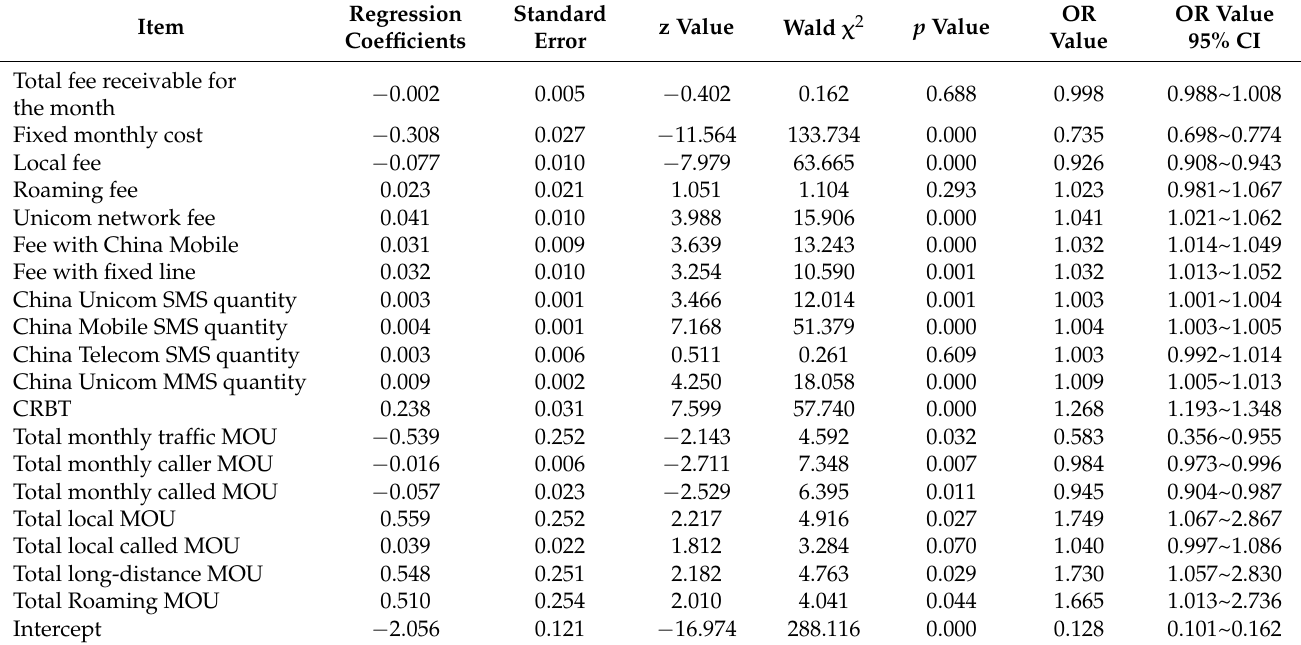
Table 21. Binary logistic regression.